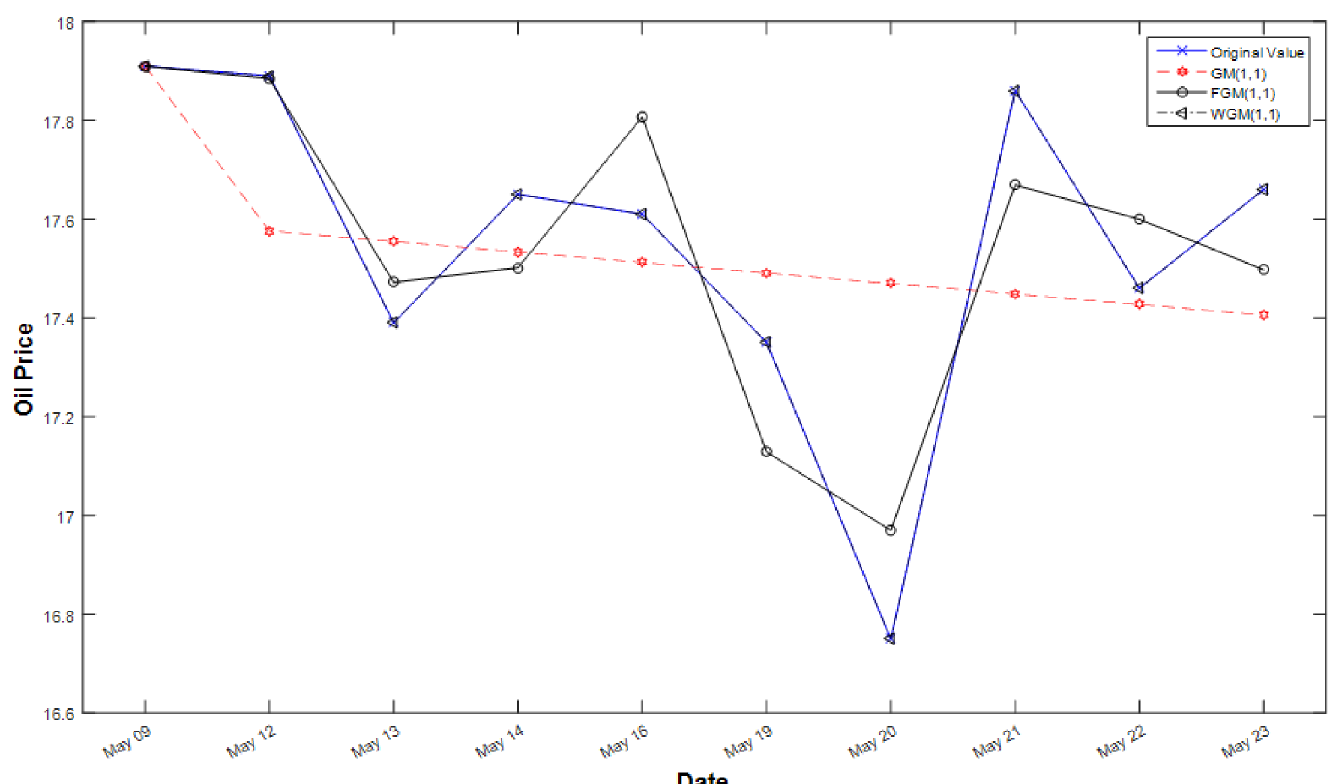
Fig 2. Line graphs of simulated values after processing of the three